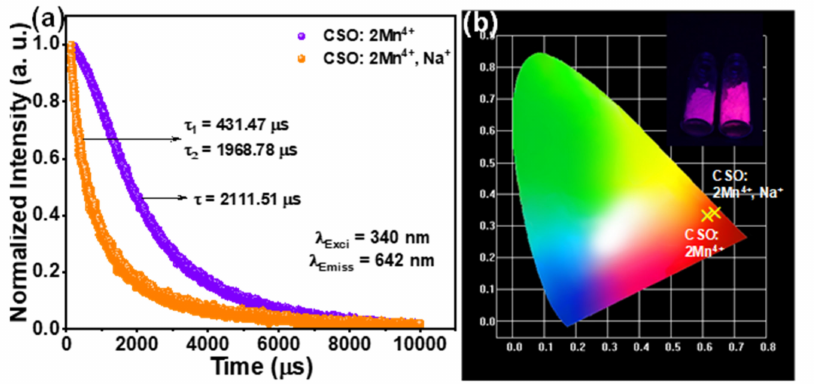
Figure 6. ( a ) Decay curves of CSO: 2Mn 4+ and Na + -doped CSO: 2Mn 4+ , ( b ) CIE chromaticity diagram for the prepared phosphors. The inset of ( b ) shows the powder images under 365 nm ultraviolet